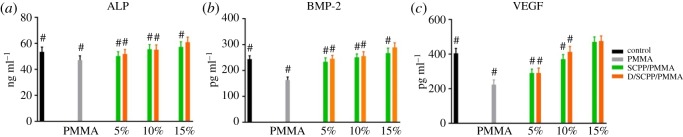
The effect of various bone cement specimens on (a) ALP, (b) BMP-2 and (c) VEGF secretion from MG63 cultured with materials (#significant difference with 15% D/SCPP/PMMA group; p < 0.05).